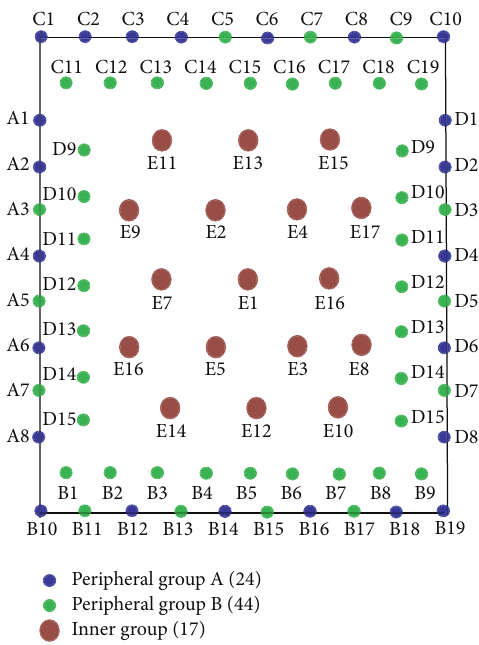
Figure 12: Distribution of 3 groups of boreholes.